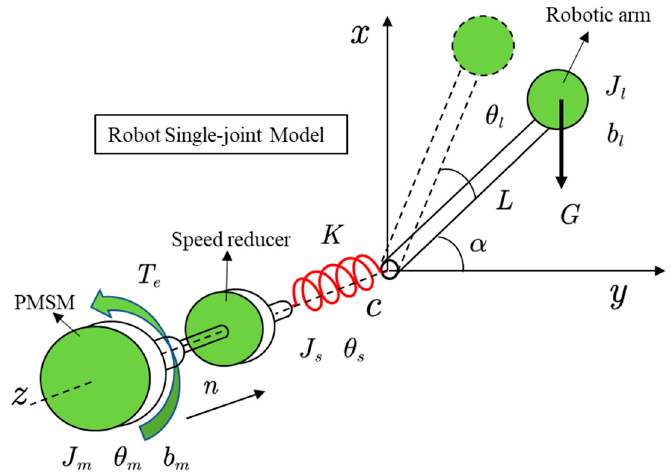
Figure 2. The double inertia model of the robot joint.